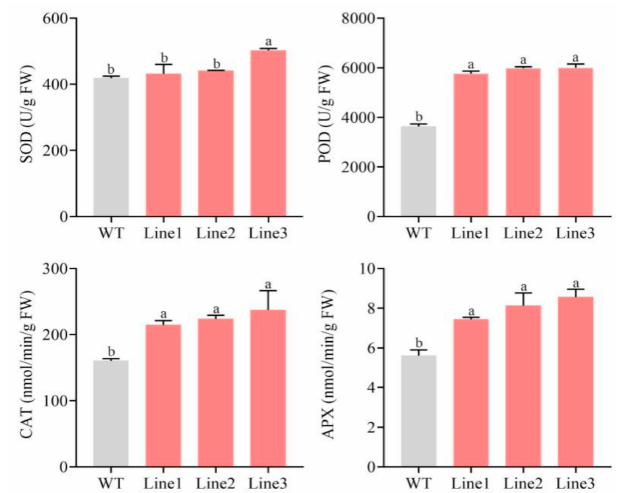
Figure 8. Antioxidant enzyme activities of WT and transgenic lines under drought stress. Tobacco plants were stressed by drought for 10 days. The values represent the mean ± SD, and different letters indicate significant differences according to Duncan’s multiple range test ( p <